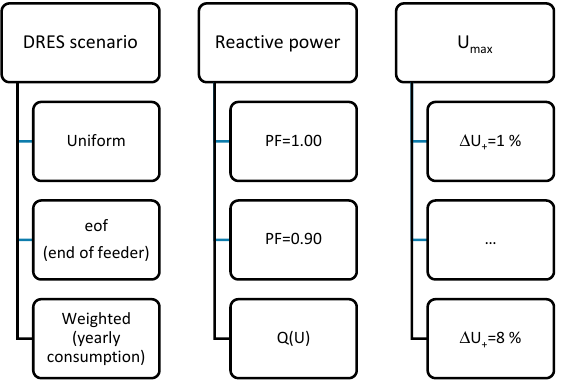
Figure 2. Considered scenarios.